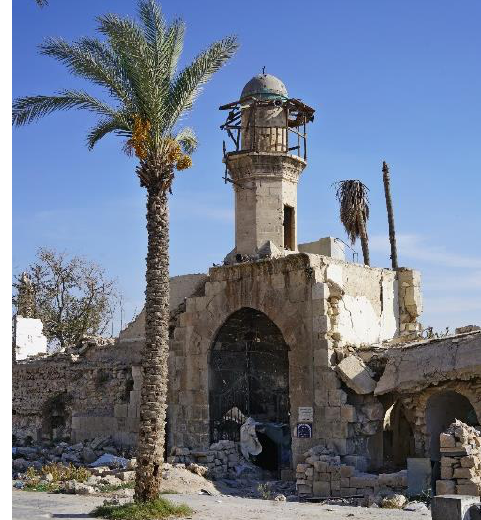
Figure 12: Al-Sultanieh, Mosque, Ayyubids, 1223 D.C. It was containing the tomb of Zaher al-Ghazi, sun of Saladin, the